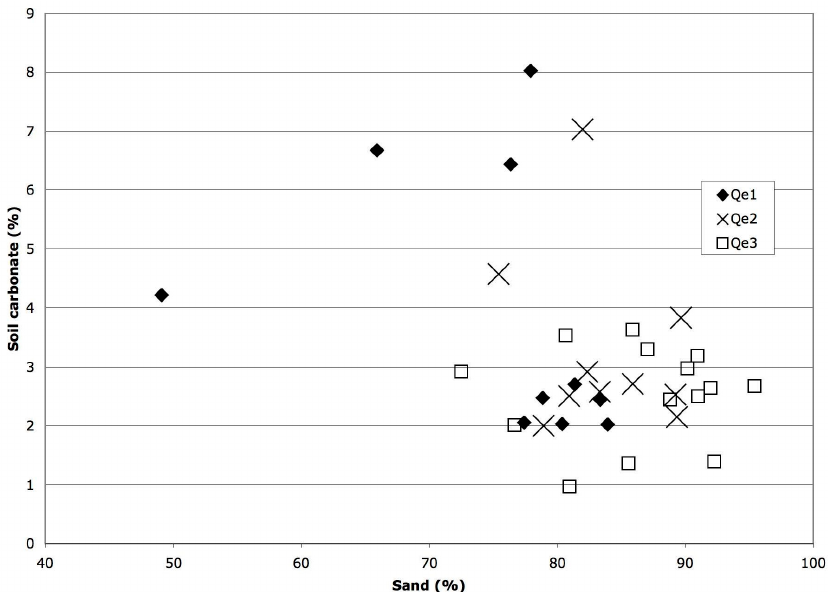
Figure 10. Sand and carbonate percentages for the most competent soil horizons in Qe1 (Btk horizons) and Qe2 (Bk or Bwk horizons). All Qe3 horizons listed in Table 4 are plotted in this figure. Aeolian units are indistinguishable based solely on texture and mass of soil carbonate.